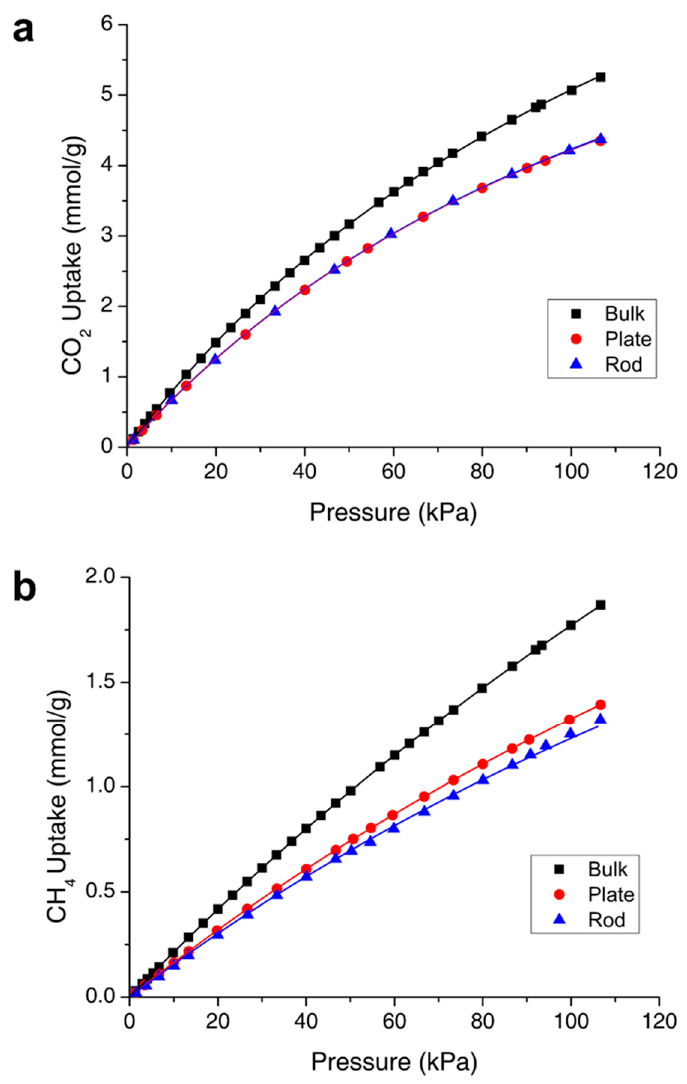
Figure 4. Adsorption isotherms for bulk, plate and rod morphologies of [Zn 2 (NDC) 2 (DABCO)] n at 273 K for ( a ) CO 2 and ( b ) CH 4 . Table 3. Langmuir isotherm fitting parameters ( a m and b ), Henry’s constant ( K ) and CO 2 /CH 4